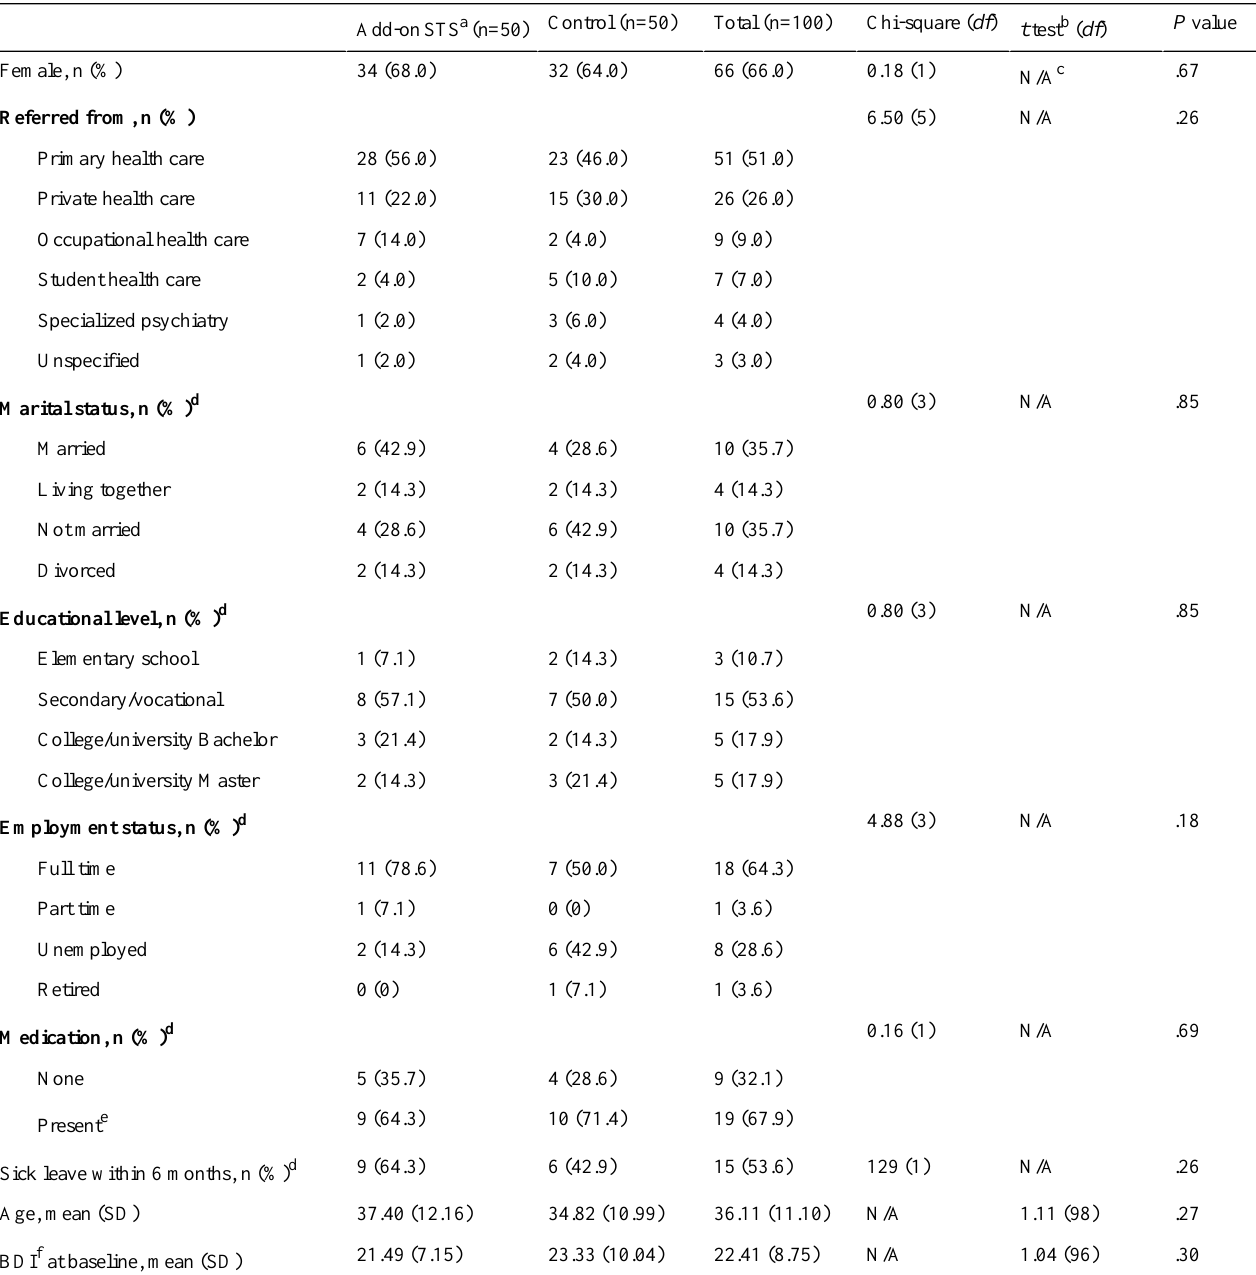
Table 1. Baseline group